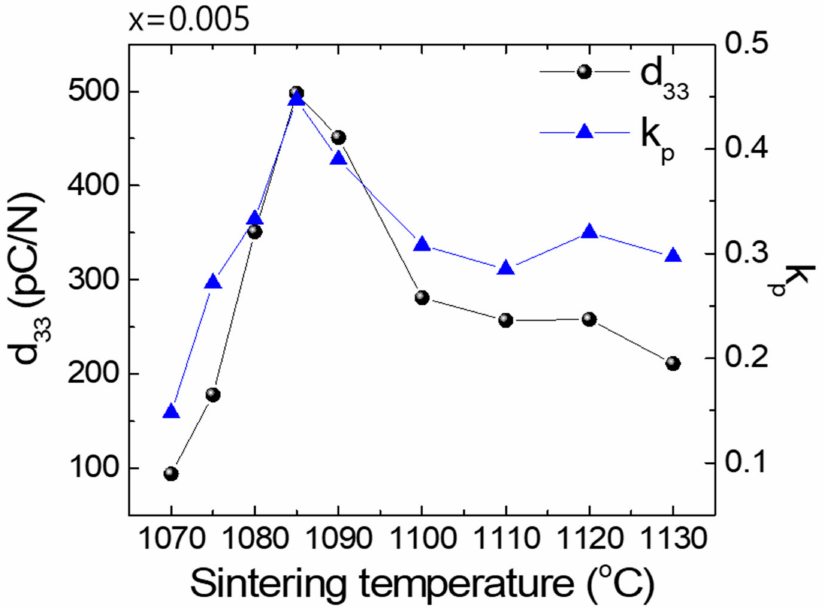
Figure 6. Piezoelectric charge coefficient (d 33 ) and electromechanical coupling coefficient (k p ) of the x = 0.005 specimen sintered at various temperatures for 4